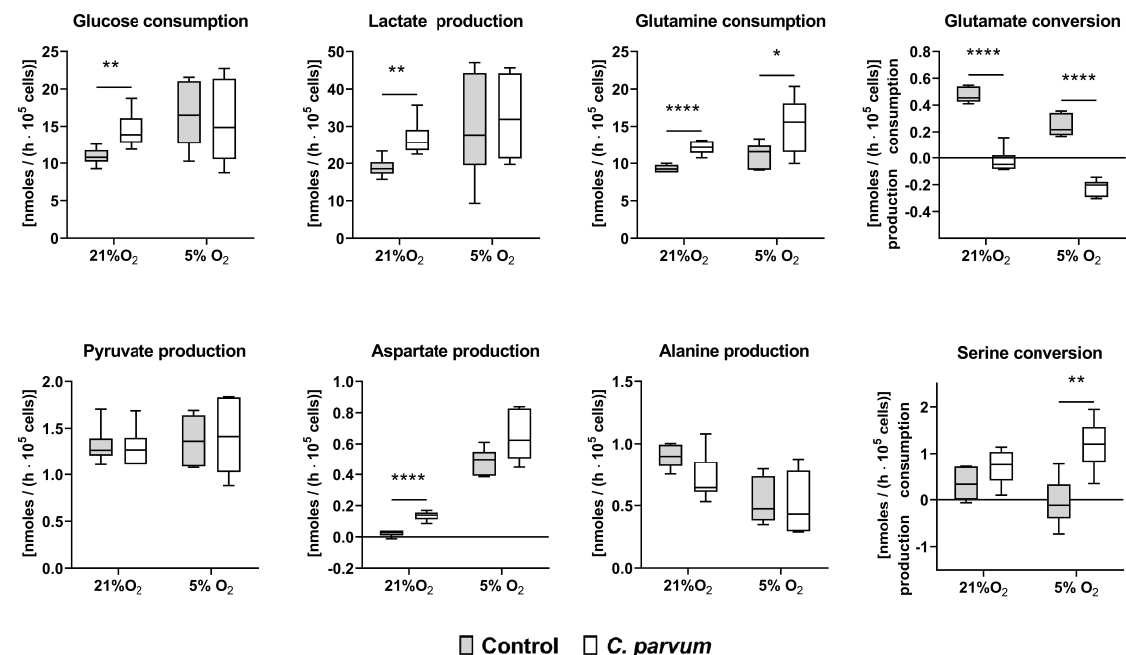
Figure 3. Glucose, lactate, pyruvate, aspartate, glutamine, glutamate, alanine and serine conversion rates in uninfected and C. parvum -infected HCT-8 cultivated in glutamine supplemented medium (2 mM) under hyperoxic (21% O 2 ) and physioxic (5% O 2 ) conditions ( n = 6, each group). Metabolite conversion rates were analyzed at 24 h p. i. in the cultivation supernatants of the cells and presented as interleaved box and whiskers plots with line at median, bars indicating maximum and minimum values. Statistical significance (* = p ≤ 0.05, ** = p ≤ 0.01, **** = p ≤ 0.0001) was evaluated by t -test for independent samples.